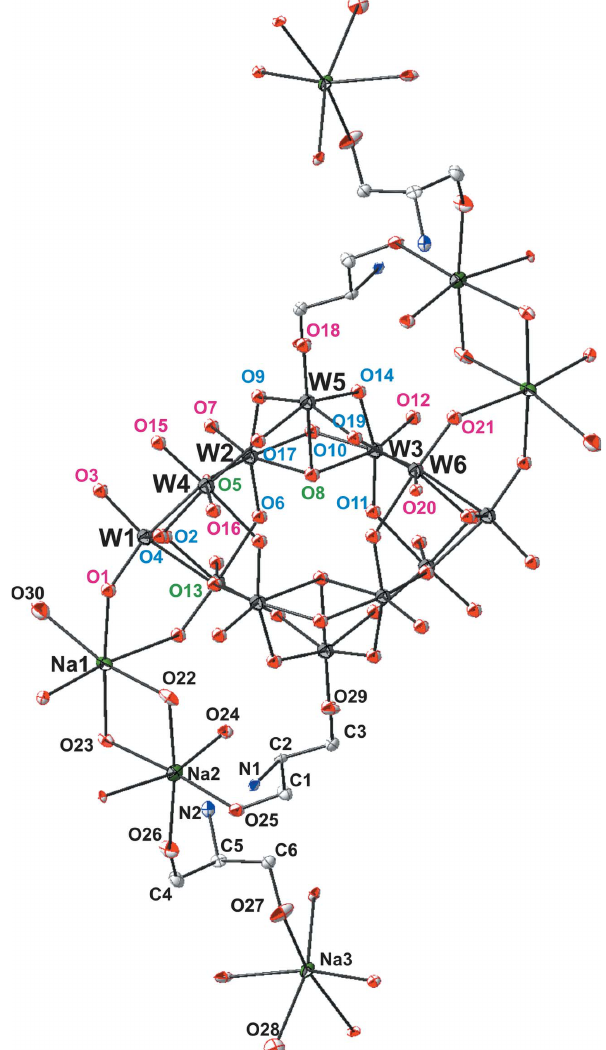
Figure 1 The principal building units in the crystal structure of [Na 6 ((CH 2 OH) 2 CHNH 3 ) 4 ][W 12 O 40 (OH) 2 ] (cid:2) 10H 2 O. The asymmetric unit was doubled considering the inversion center, and coordination spheres for all cations were completed. Labeling of all atoms of asymmetric unit is shown; non-labeled atoms are generated by symmetry operation (cid:4) x + 1, (cid:4) y + 1, (cid:4) z + 1. The oxygen atoms in the paratungstate B anion are labeled according to their coordination mode: magenta for the terminal, blue for the double bridging, green for the triply bridging oxygen ions. Displacement ellipsoids are drawn at the 50% probability level. Color code: W, dark gray; Na, green; C, gray; N, blue; O,